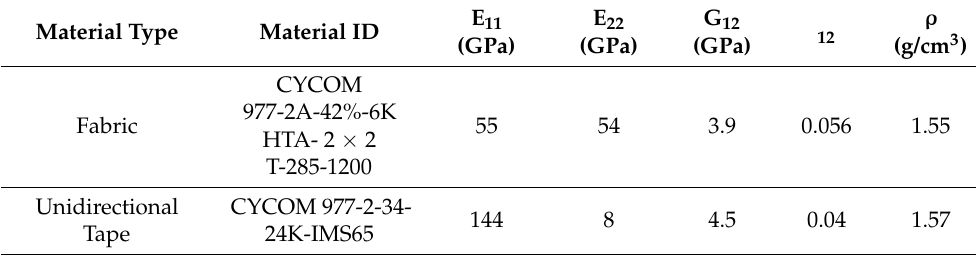
Table 1. Material Lamina